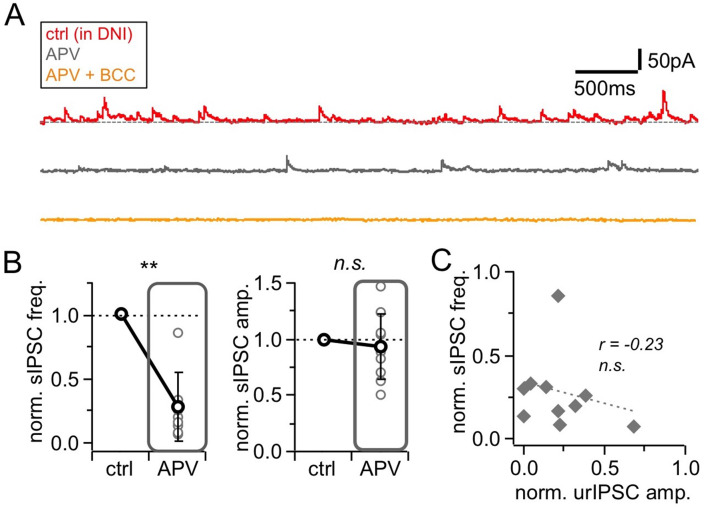
Effects of NMDAR blockade by D-APV (APV, 25 µM) on spontaneous activity.(A) Representative experiment showing voltage-clamp recordings (+10 mV) from a mitral cell in the presence of DNI (control, top trace), upon addition of APV (middle trace) and further wash-in of BCC (50 µM; bottom trace). (B) sIPSCs in control and in presence of APV (n = 10 MCs). Left: Frequency. Right: Amplitude. sIPSCs were abolished in BCC (analysis not shown) (C) Linear regression between the APV effect on sIPSC frequency vs urIPSC amplitude (n = 10 MCs). No significant correlation.